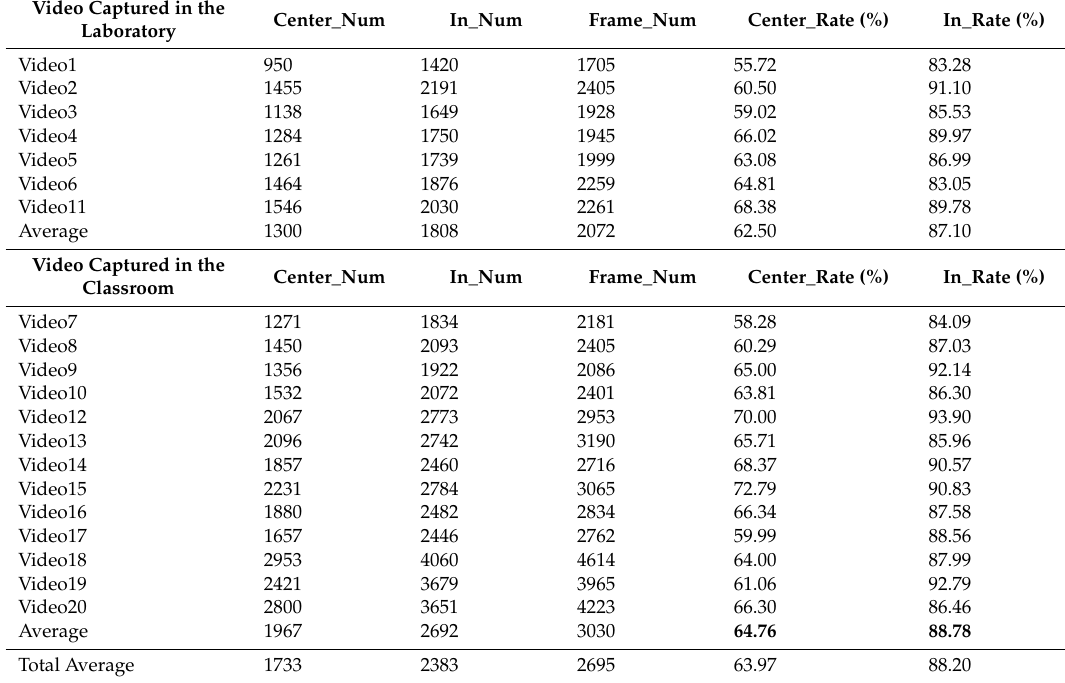
Table 5. The results of twenty videos captured in two